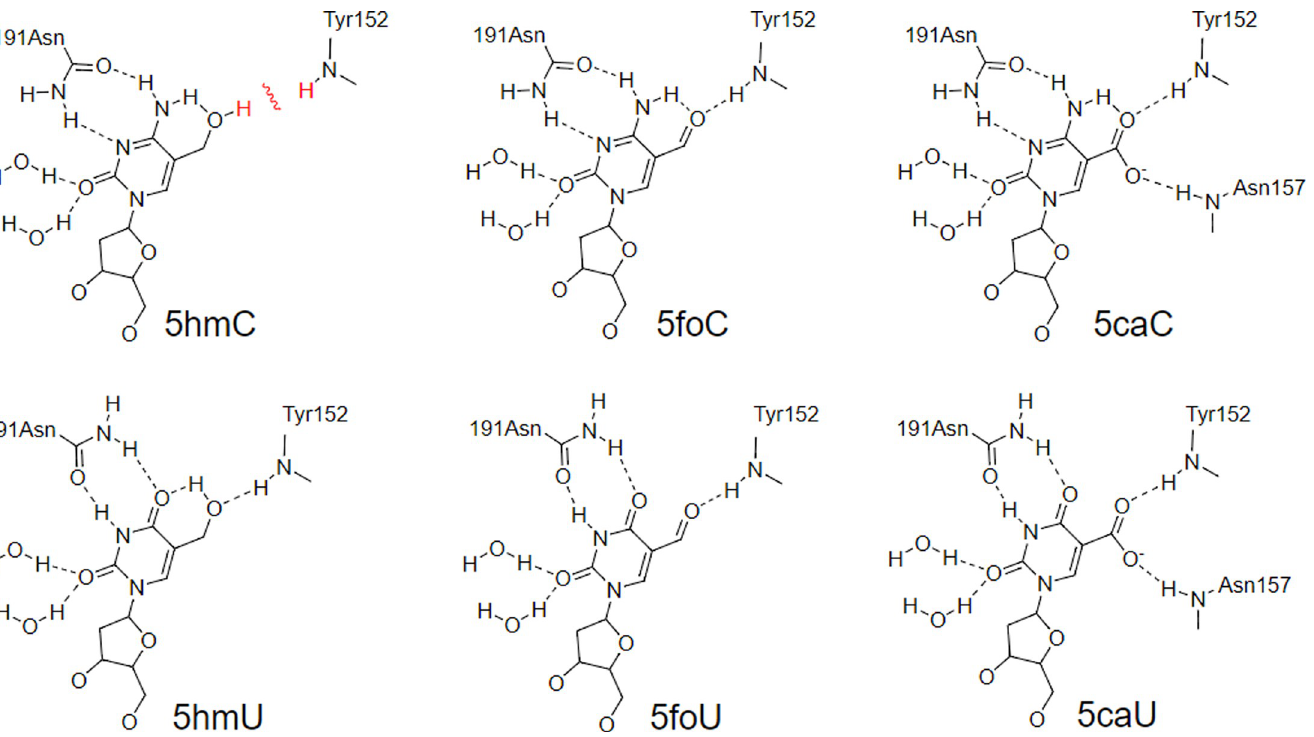
Fig 8. Potential hydrogen bonding interactions in the catalytic pocket of hTDG that allows recognition of 5foC, 5caC, 5hmU, 5foU, and 5caU, but not 5hmC.